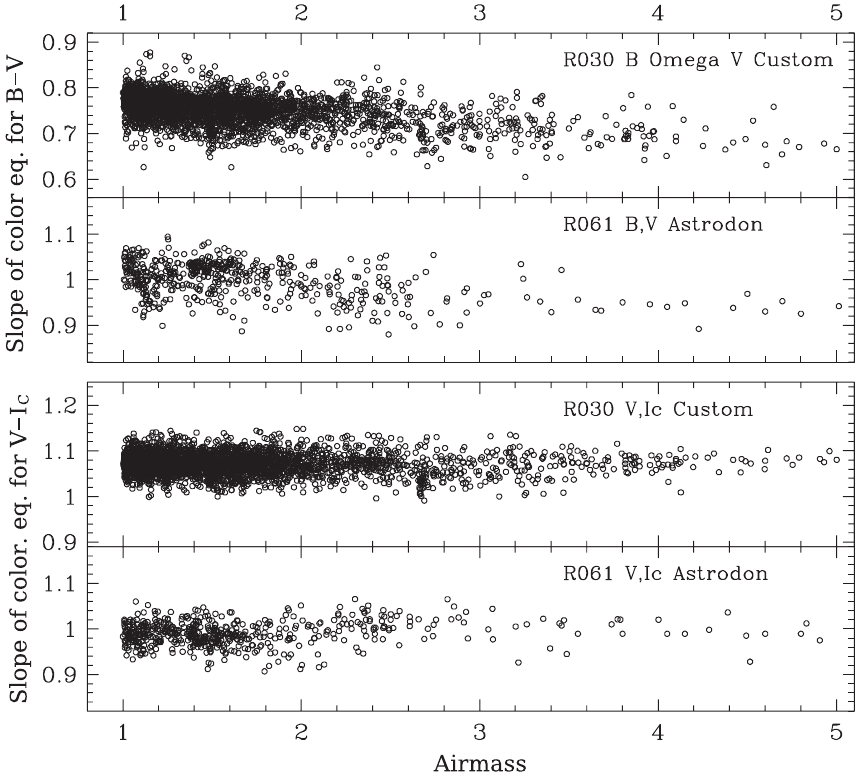
Fig. 5. Dependence of the (cid:12) slopes of Eq. (1) color-equations on airmass for two of the ANS Collaboration telescopes. A dependence on airmass is present for B (cid:0) V and it is negligible for V (cid:0) I C (and for V (cid:0) R C and R C (cid:0) I C as well). The plots for other ANS instruments are